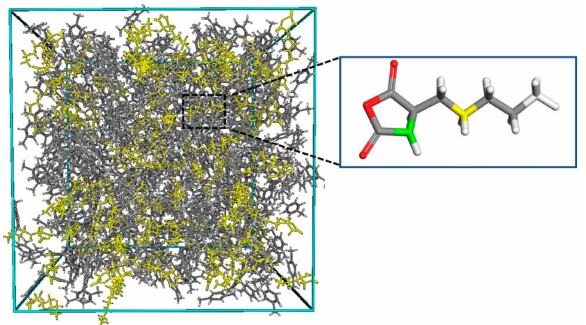
Figure 4. Cubic simulation cell (yellow parts represent composite monomers) and repeating unit structure (green atom is the initiated central atom; yellow atom is the head